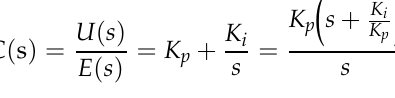
Figure 12. Block diagram of actuator control system.